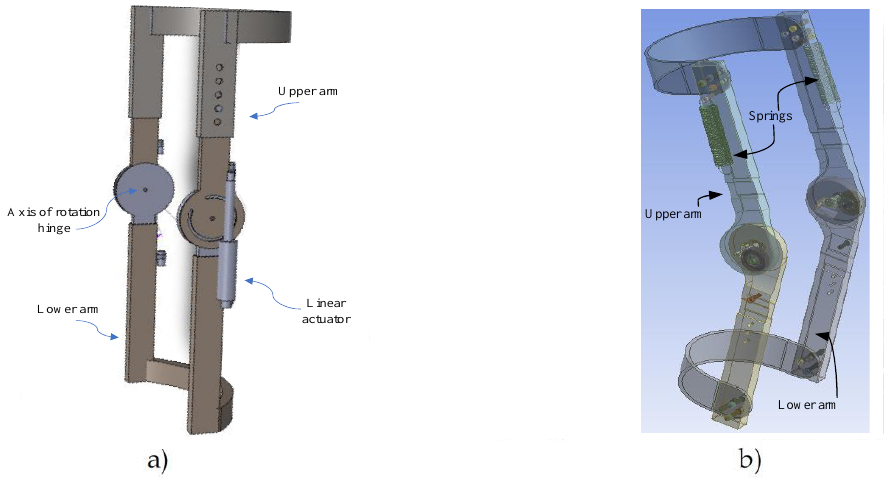
Figura 15 a), el cual se dibuj ó en solidworks, despues se busco simplificar el Figure 14. Type force element used: ( a ) active (actuator); ( b ) passive (springs). From the documents (patent and research articles), we can determine that the designs, on average, have a range of mobility of the structure from 0 to 120 degrees, and the actuators, on average, provide a torque of 95 to 150 Nm and power from 50 to 235 watts. On average, when it comes to the use of springs, they generate a force of approximately 85 N.